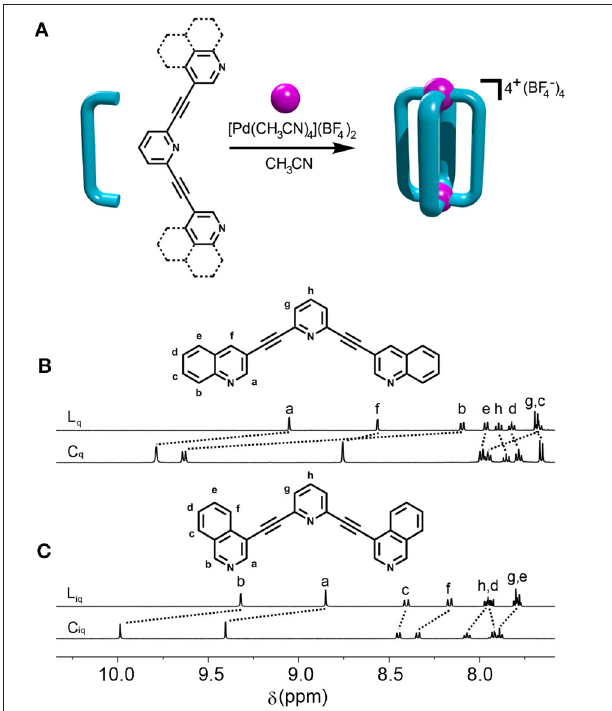
FIGURE 1 | (A) General scheme for formation of [Pd 2 ( L ) 4 ] 4 + cages ( C q and C iq ) and partial 1 H NMR spectra (400 MHz, CD 3 CN, 298K) of (B) L q and C q , and (C) L iq and C iq .